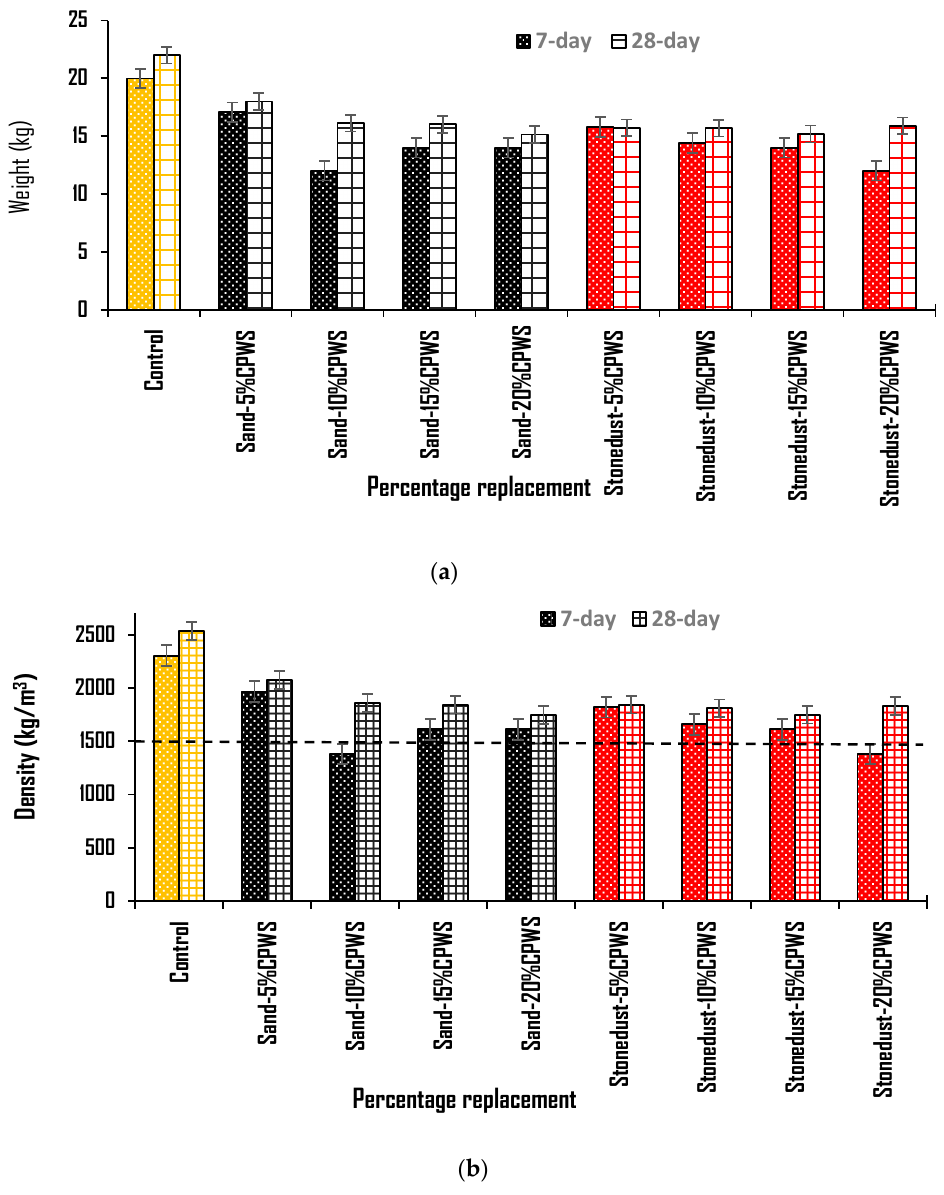
Figure 4. ( a ) Weight of hollow block samples at 7 and 28 days. ( b ) Density of hollow block samples at 7 and 28 days.